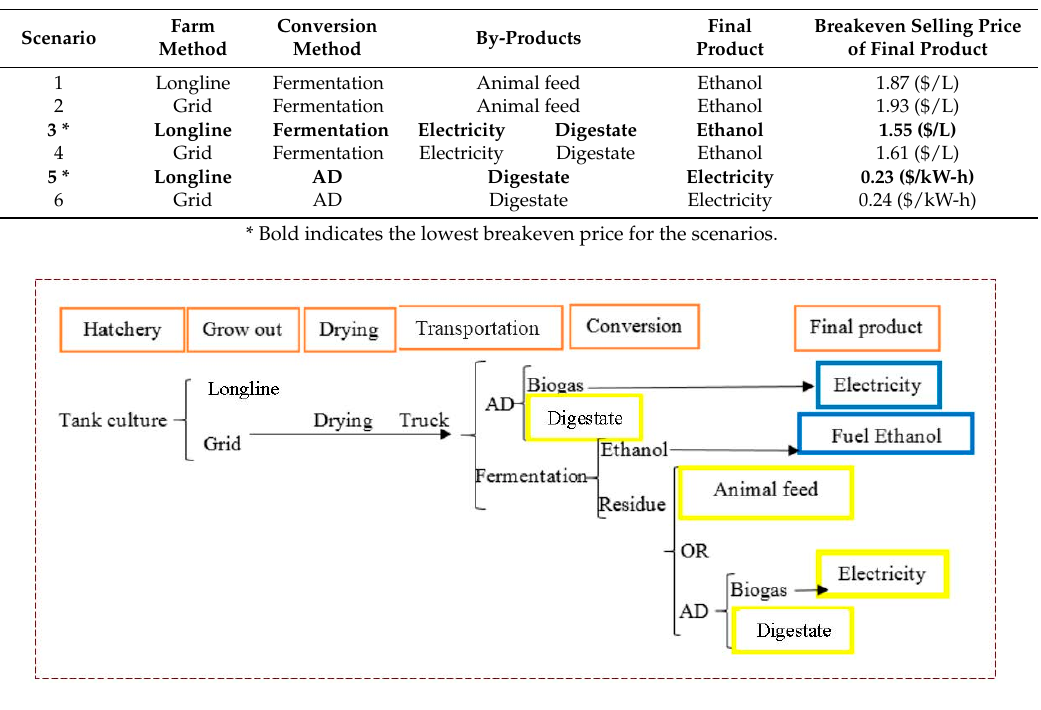
Figure 1. Overview of the supply chain and biofuel production methods. Orange rectangles indicate the main steps, blue rectangles indicate the final products in each scenario, and yellow indicate the by-products in each scenario. The red dashed box indicates the system boundary.